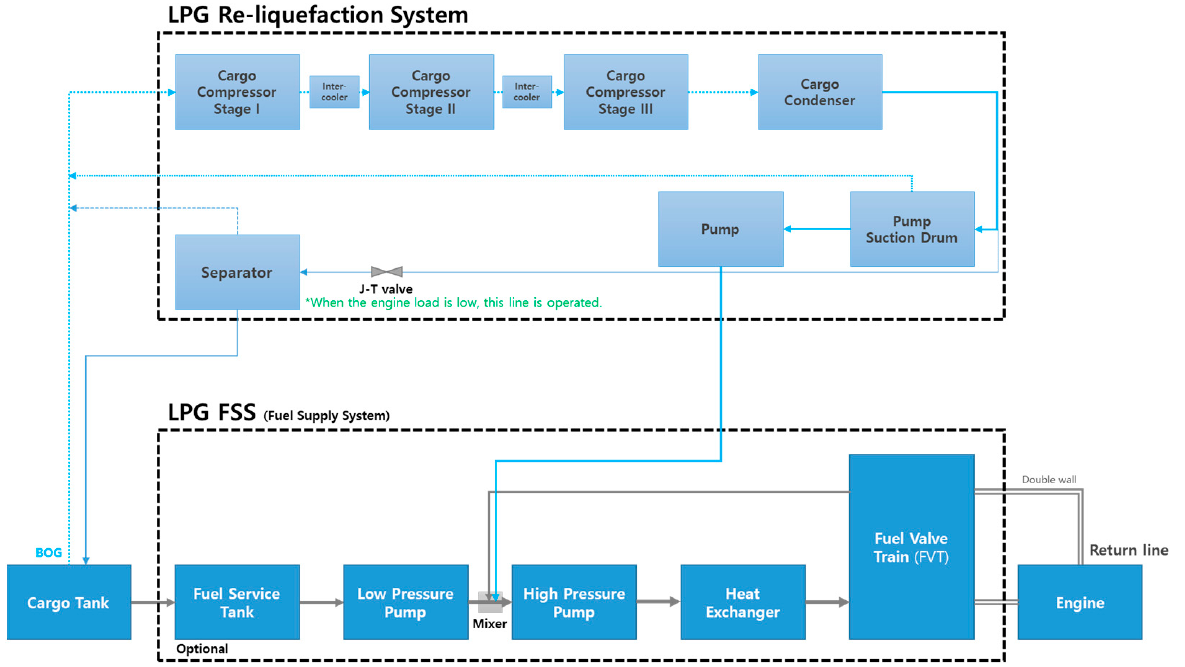
Figure 3. Block diagram of re-liquefaction and fuel supply systems in novel LPG-fuelled LPG carrier.